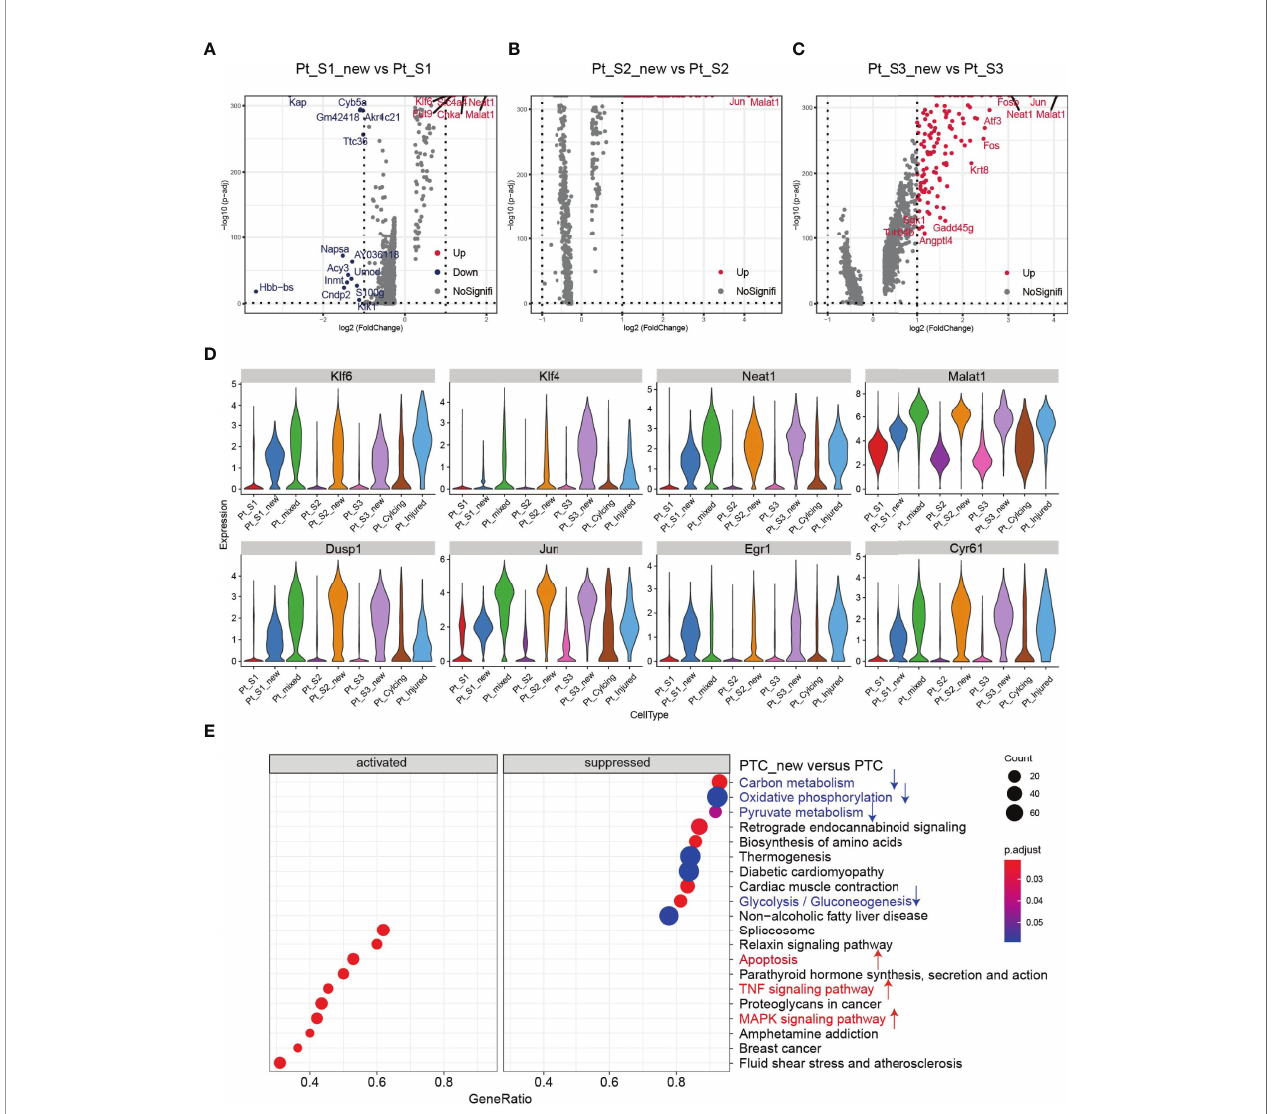
FIGURE 3 | Transcriptomic features of PTC-new subtypes. (A – C) Volcano plot showing the differentially expressed genes in PTC-S1-new versus PTC-S1 (A) , PTC- S2-new versus PTC-S2 (B) , PTC-S3-new versus PTC-S3 (C) . (D) The expression level of representative kidney injury or repair regulated signatures in PTC subtypes. (E) Enriched gene ontogeny (GO) among PTC-new subtypes versus normal